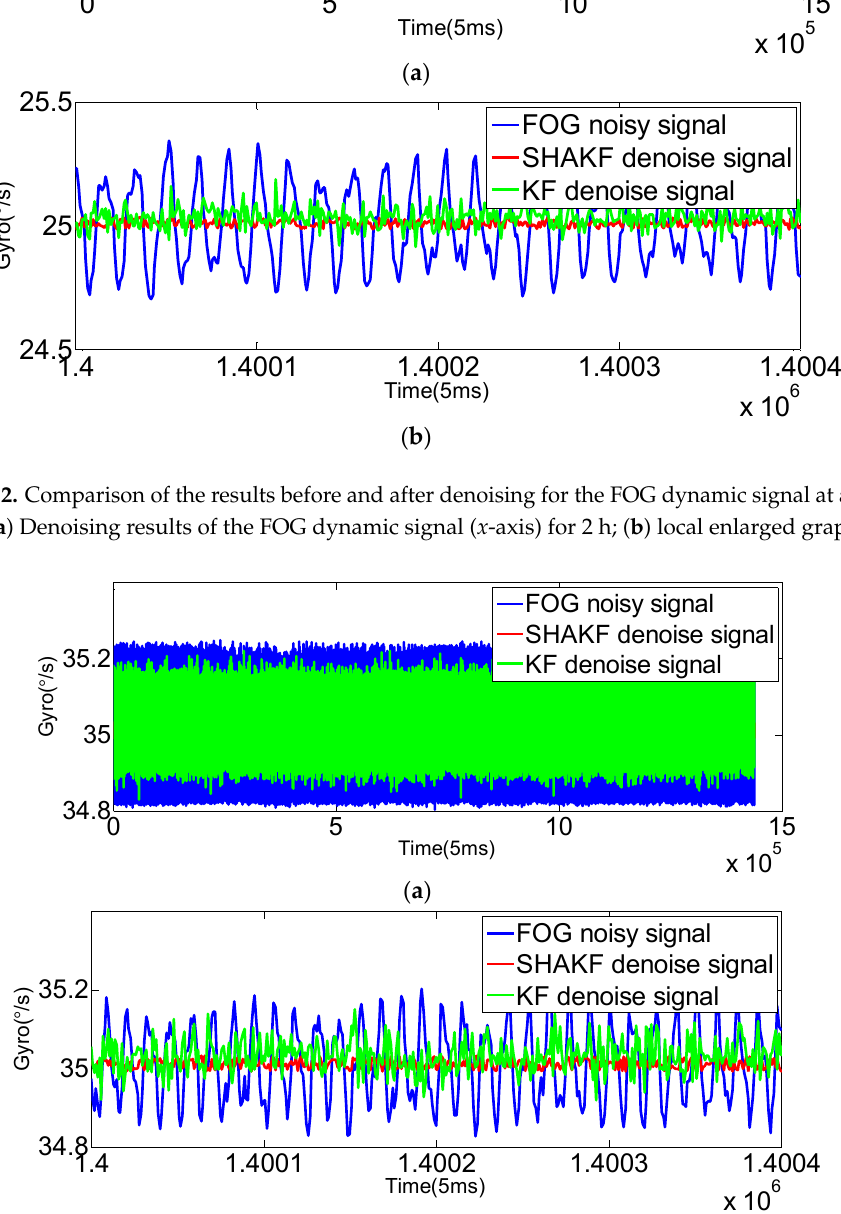
Figure 13. Comparison of the results before and after denoising for the FOG dynamic signal at a rate of 35°/s. ( a ) Denoising results of the FOG dynamic signal ( x -axis) for 2 h; ( b ) local enlarged graphs.